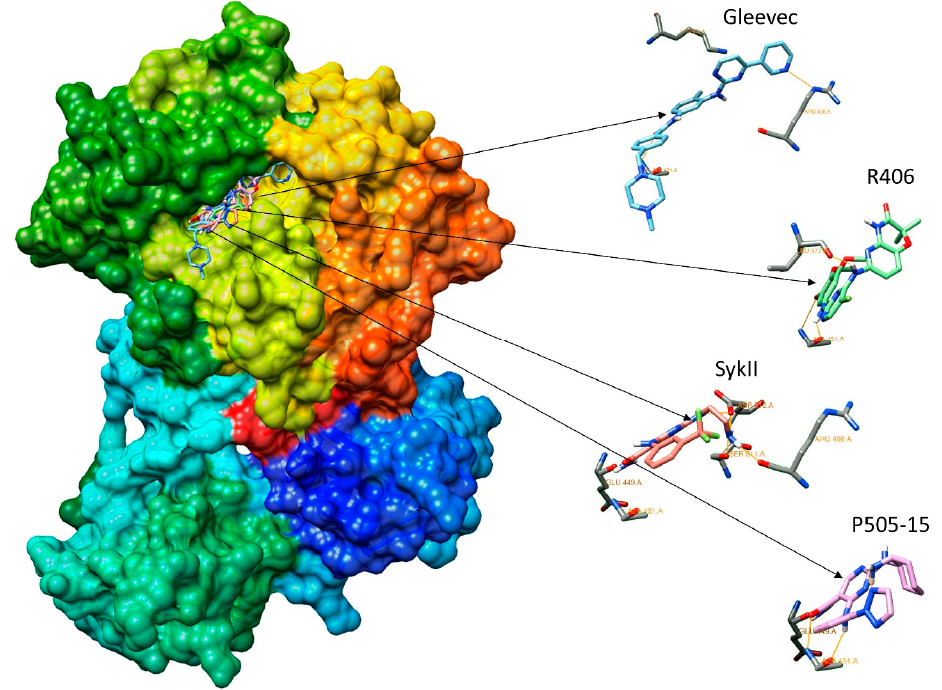
Figure 5. The 3D surface structure of Syk protein, showing Syk inhibitors interacting in the catalytic site. The compounds, with the main H-bond interactions, were reported alone, outside of the pocket of binding.